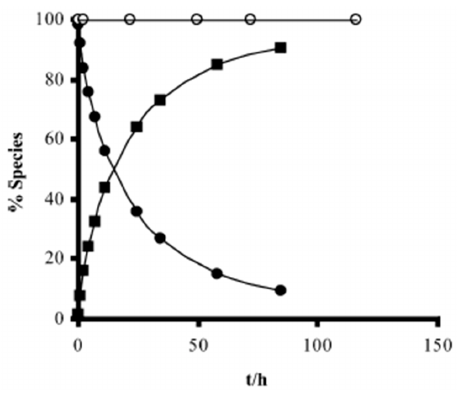
Figure 37. Time courses for components ( 87c ) ( ⚬ ), Ala-PQ ( ● ) and PQ ( ■ ) when ( 87c ) and Ala-PQ were incubated in 80% human plasma at 37 °C (reproduced from [135]).